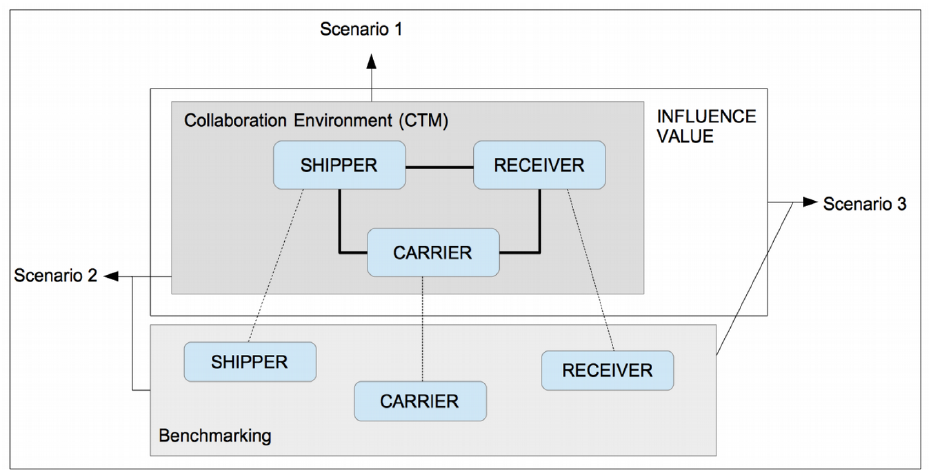
Figure 1. Simulation